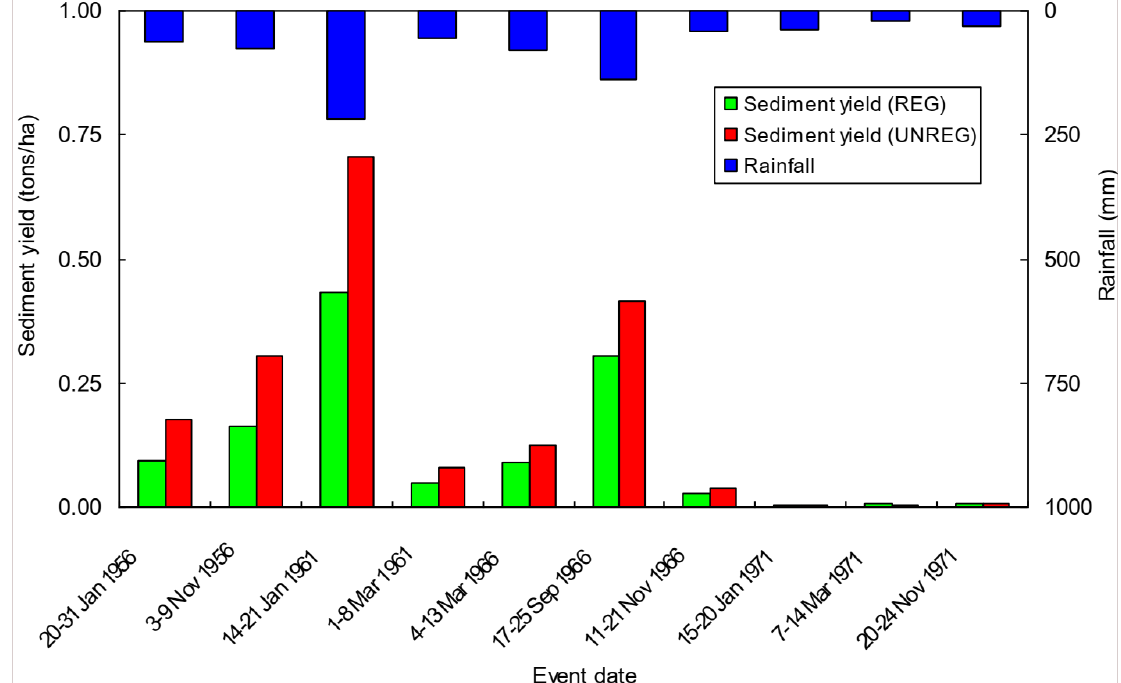
Figure 9. Rainfall height and sediment yield simulated by the MUSLE equation in unregulated (UNREG) and regulated (REG) sub-catchments (Calabria, Southern Italy)—events are not reported on time